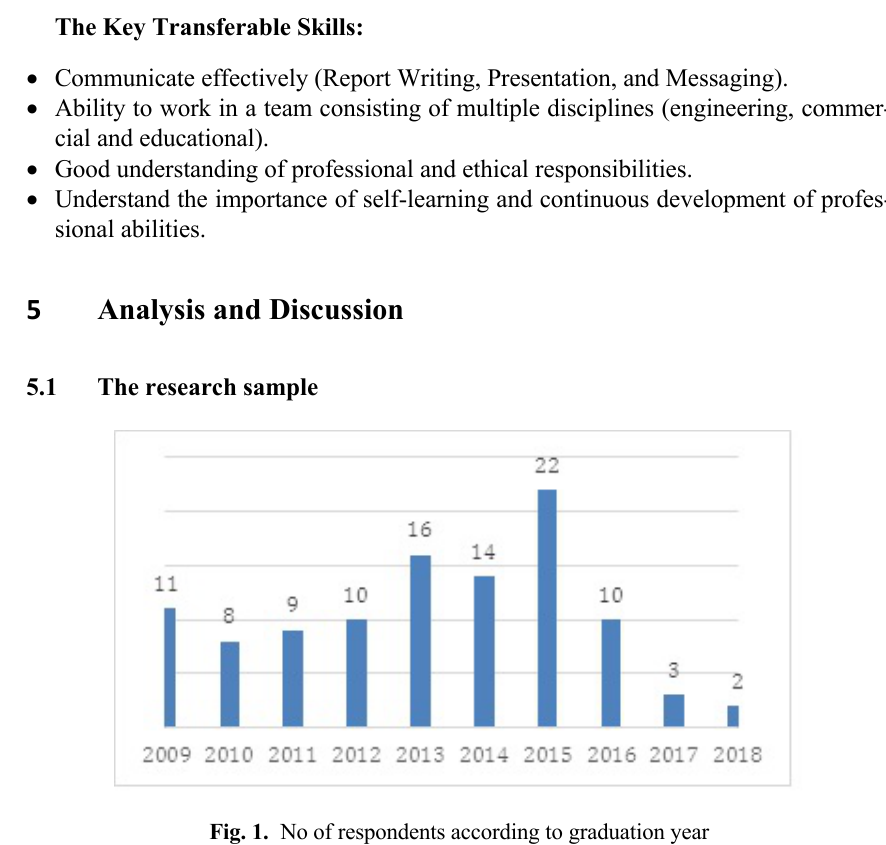
Fig. 1. No of respondents according to graduation year